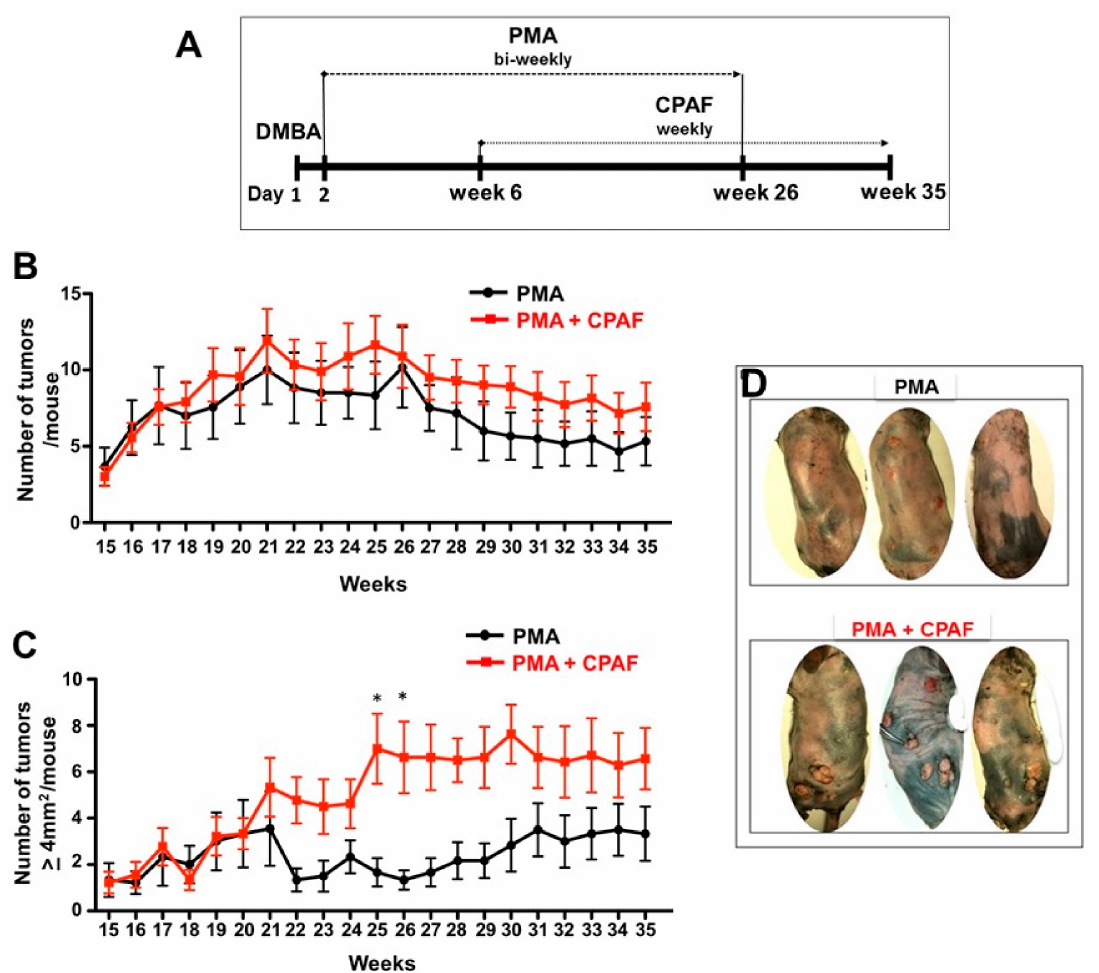
Figure 1. Effect of systemic CPAF on DMBA/PMA-induced tumor growth. ( A ) Schematic representation of our working model. Six weeks old C3H/NeH mice were treated topically with DMBA (100 µ g/mouse for two consecutive days) followed by the treatments with PMA (50 µ g/mouse; topically) with or without CPAF (250 ng/mouse; i.p.) for specific time points. ( B ) Total number of non-melanocytic tumors/mouse in PMA and PMA + CPAF groups is shown. ( C ) Total number of non-melanocytic tumors ≥ 4 mm 2 /mouse in PMA and PMA + CPAF groups is presented. ( D ) Representative photographs of mice from PMA and PMA + CPAF treated group is shown. * Represents statistical significance ( p < 0.05) as determined by a 2-way ANOVA with Bonferroni post-hoc